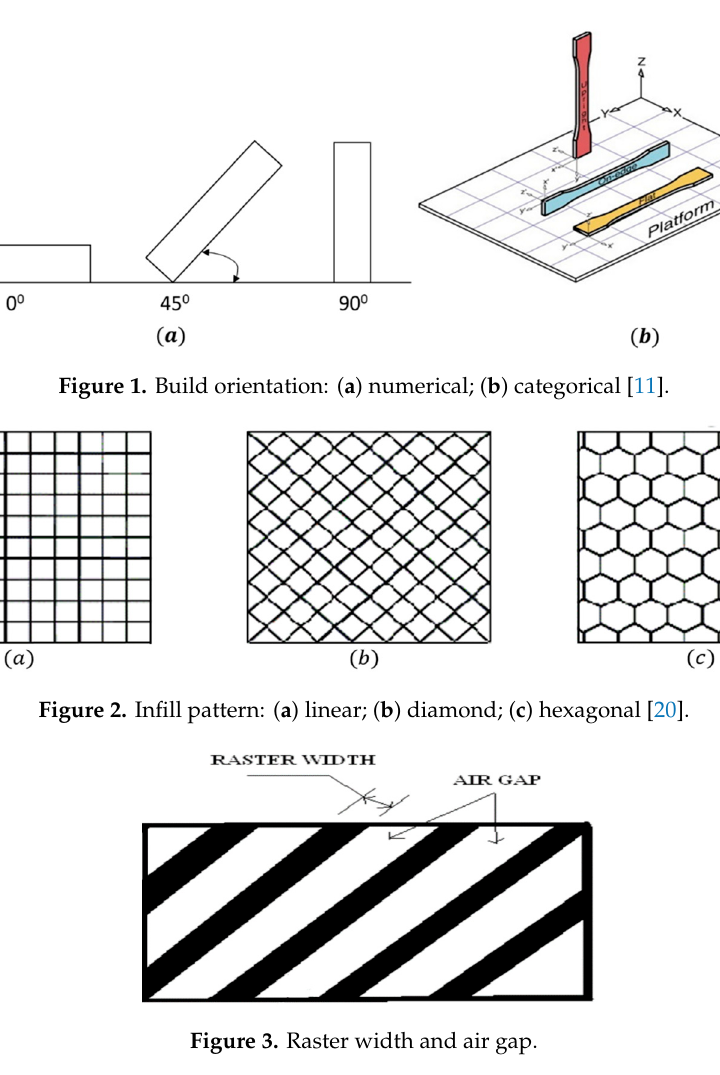
Figure 2. Infill pattern: ( a ) linear; ( b ) diamond; ( c ) hexagonal [20]. 99